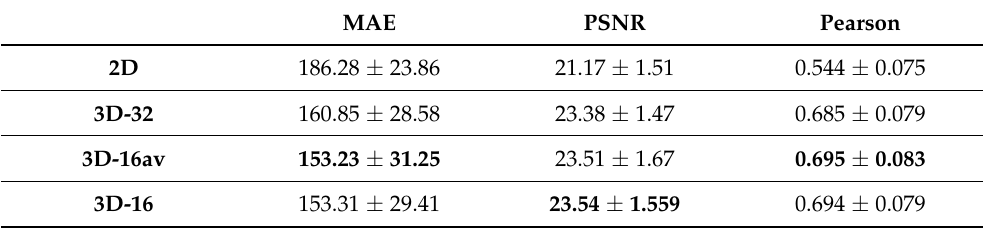
Table 7. Head dataset Fat with U-net. Mean Absolute Error, PSNR and Pearson coefficient within the fat on the head data set obtained using U-net with different convolutions and